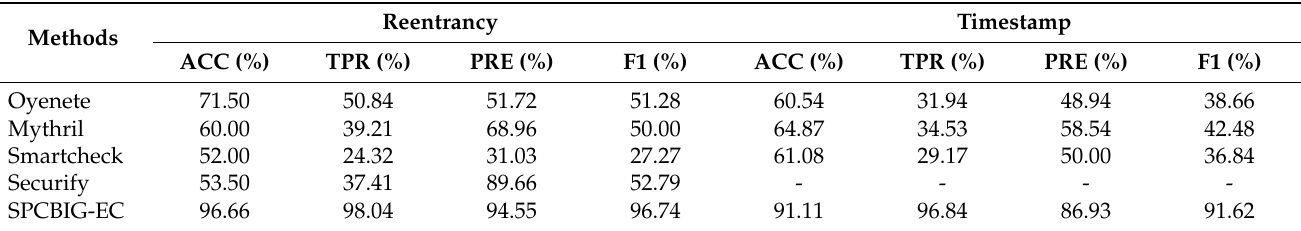
Table 7. Comparison results with advanced security audit tools.